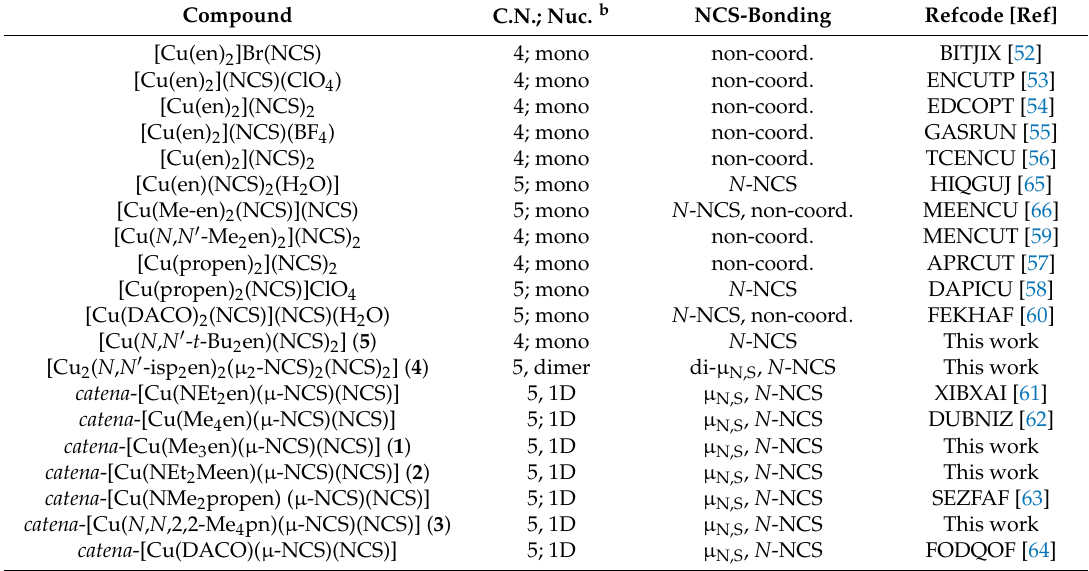
Table 3. Some structural details of Cu(II)-isothiocyanate coordination compounds derived from some N -alkyl bidentate amine ligands.